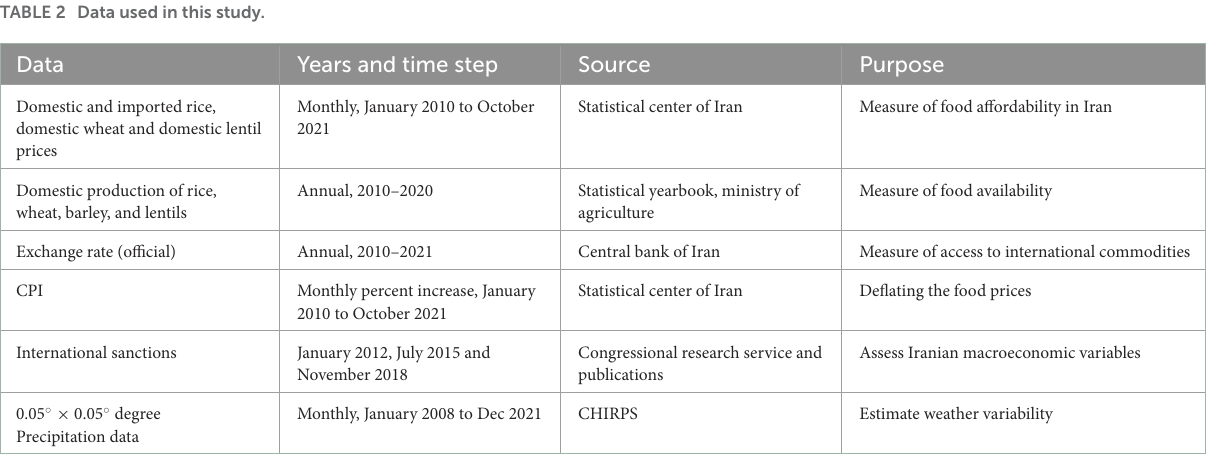
TABLE 2 Data used in this